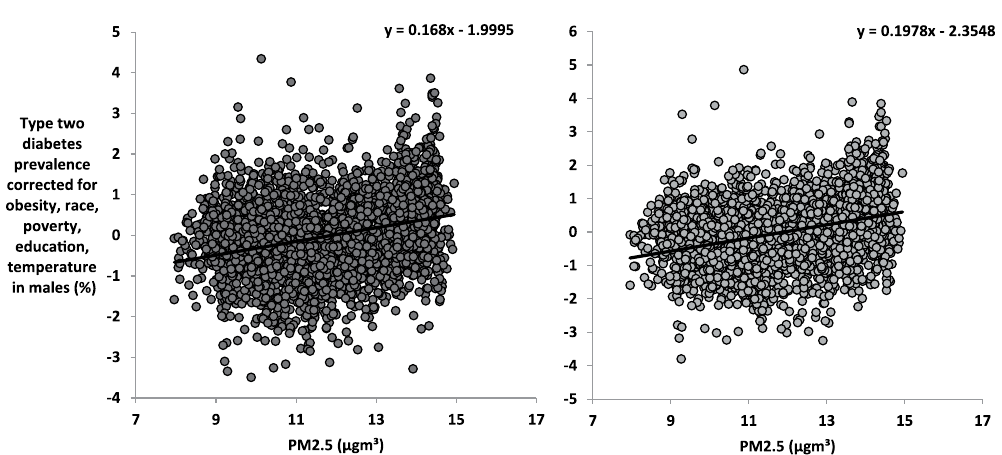
Figure 3. Association between levels of PM2.5 and T2D prevalence across the mainland USA corrected for obesity, race, poverty, education and temperature. Plots show the county level data across the USA (n = 3106) for ( A ) T2D prevalence corrected for levels of obesity, race, poverty, education and temperature against average PM2.5 ( µ g.m − 3 ) in males, ( B ) T2D prevalence corrected for levels of obesity, race, poverty, education and temperature against average PM2.5 ( µ g.m − 3 ) in